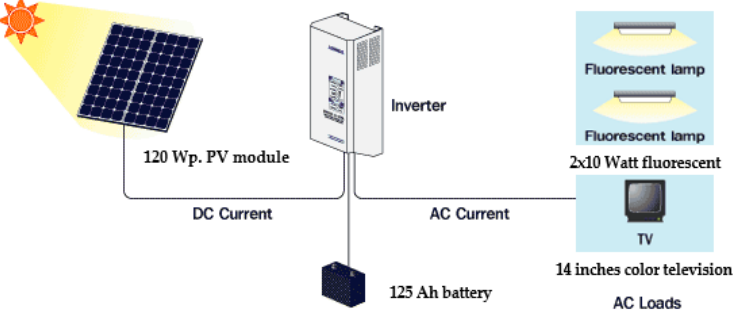
Figure 1. Sample application of PV standalone system in remote areas, Thailand [6].